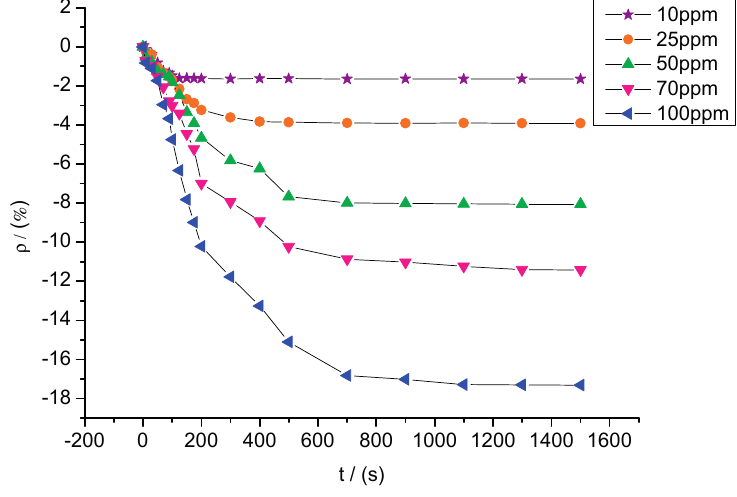
Figure 15. Response of MWNT sensors to different concentrations of SO 2 F 2